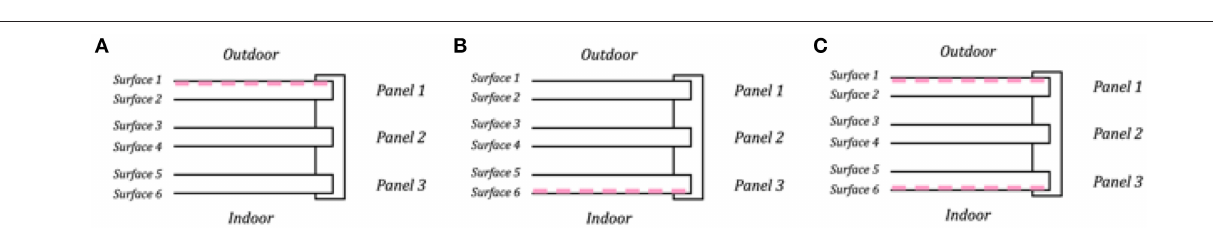
FIGURE 2 | Use cases for placing one (A,B) or two (C) capillary panels as components of a regular triple-glazing